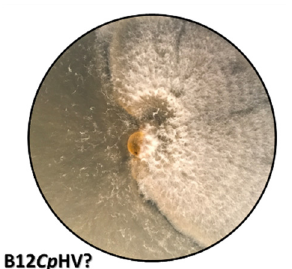
Figure 6. Putative Cp HV from secondary sampling. Two Site B isolates (B12 Cp HV?, B13 Cp *) began